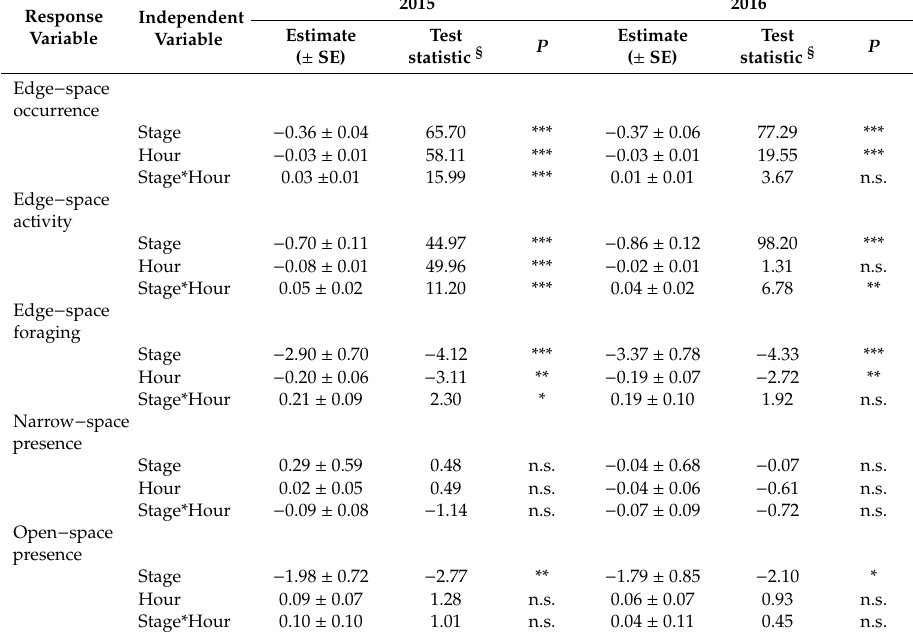
Table 3. Results of statistical analyses showing the e ff ects of hour and stage on edge-space bat occurrence, edge-space bat total activity, edge-space bat foraging, narrow-space bat presence, and open-space bat presence. Degrees of freedom (df) = 1 for all models. P = p-value with: n.s. =